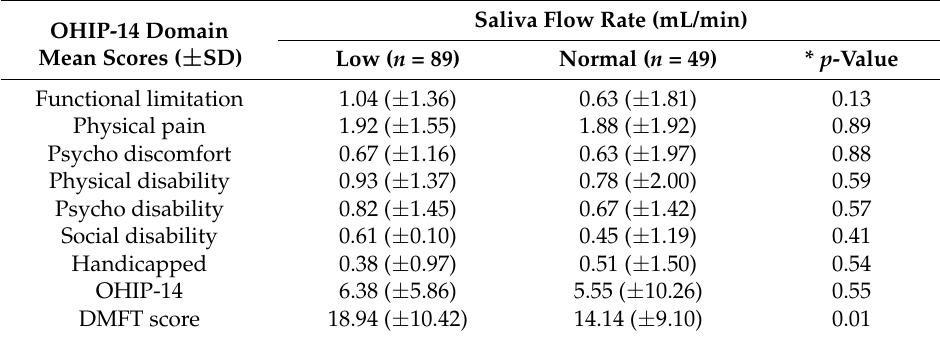
Table 6. Association between mean OHIP-14 scores, caries status, and saliva flow rate ( N = 138). OHIP-14 Domain